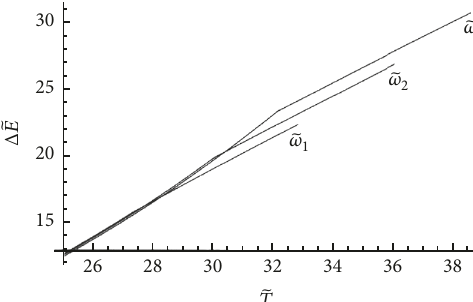
Δ𝐸(̃𝑇) = ̃𝐸(̃𝑇) − ̃𝐸 𝑏𝑝 for the